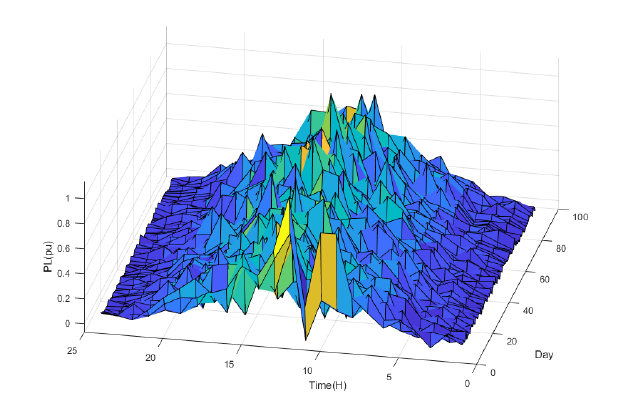
Fig. 12. The load curve profile